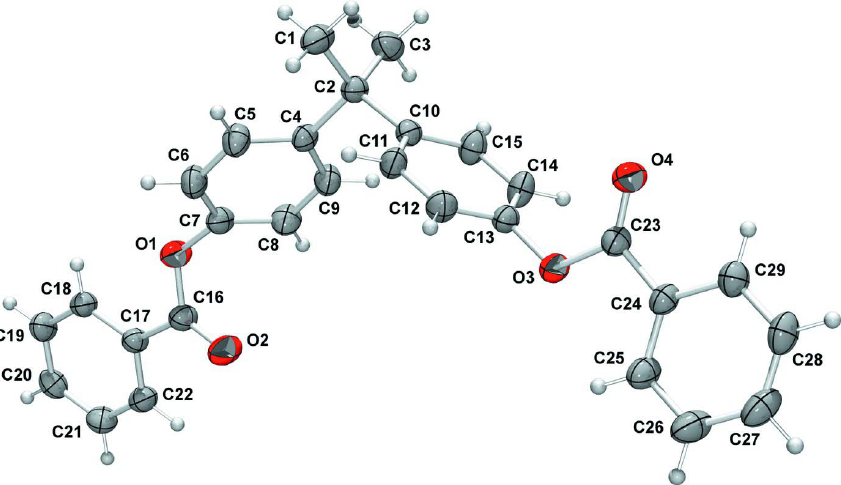
The molecular structure of the title compound, showing the atomic numbering scheme. Displacement ellipsoids are drawn at the 30% probability level and H atoms are shown as small spheres of arbitrary